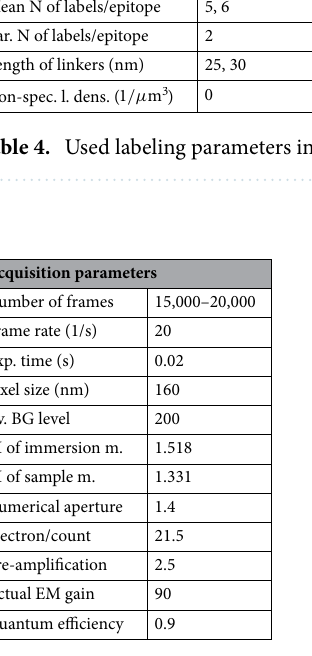
Table 5. Used acquisition parameters in